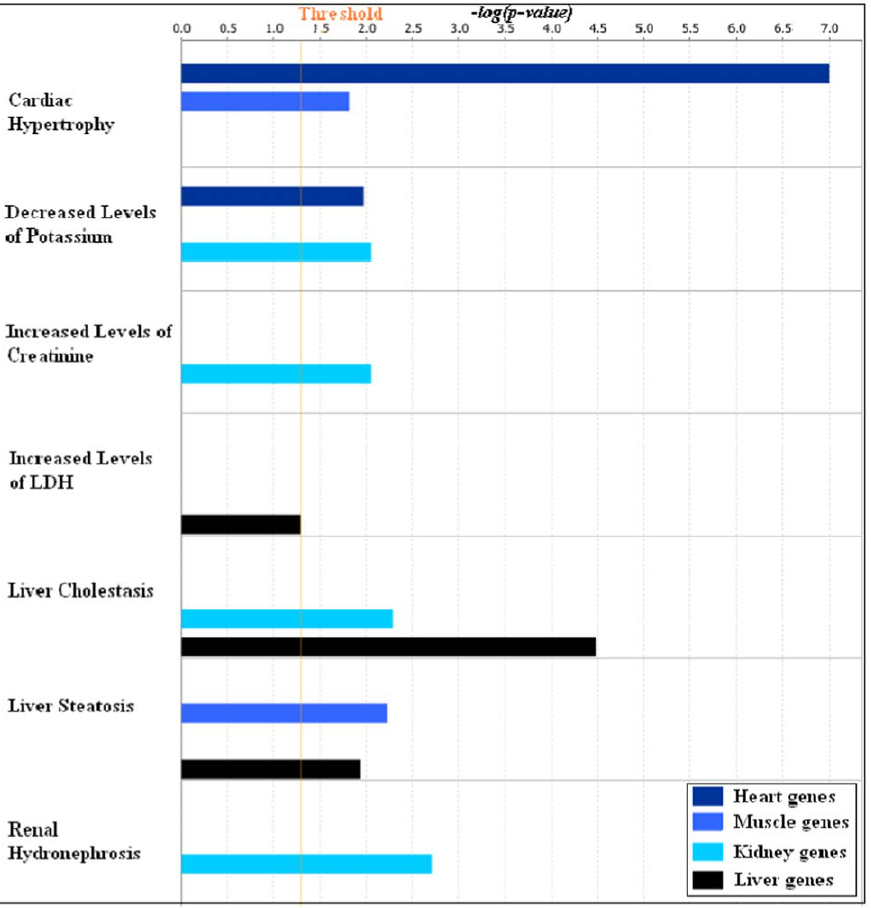
Figure 8. Enrichment of toxicity functions in the four tissue specific gene clusters. The top one hundred most influential probe-sets in the four tissue specific gene clusters obtained in the first factorization were subjected to IPA-Tox analysis in the IPA software. This graph shows the comparison of toxicity functions enriched in the four tissue specific gene clusters. The coloured bars show the significance of the enrichment for a particular toxicity functions in the cluster computed by Fisher’s exact